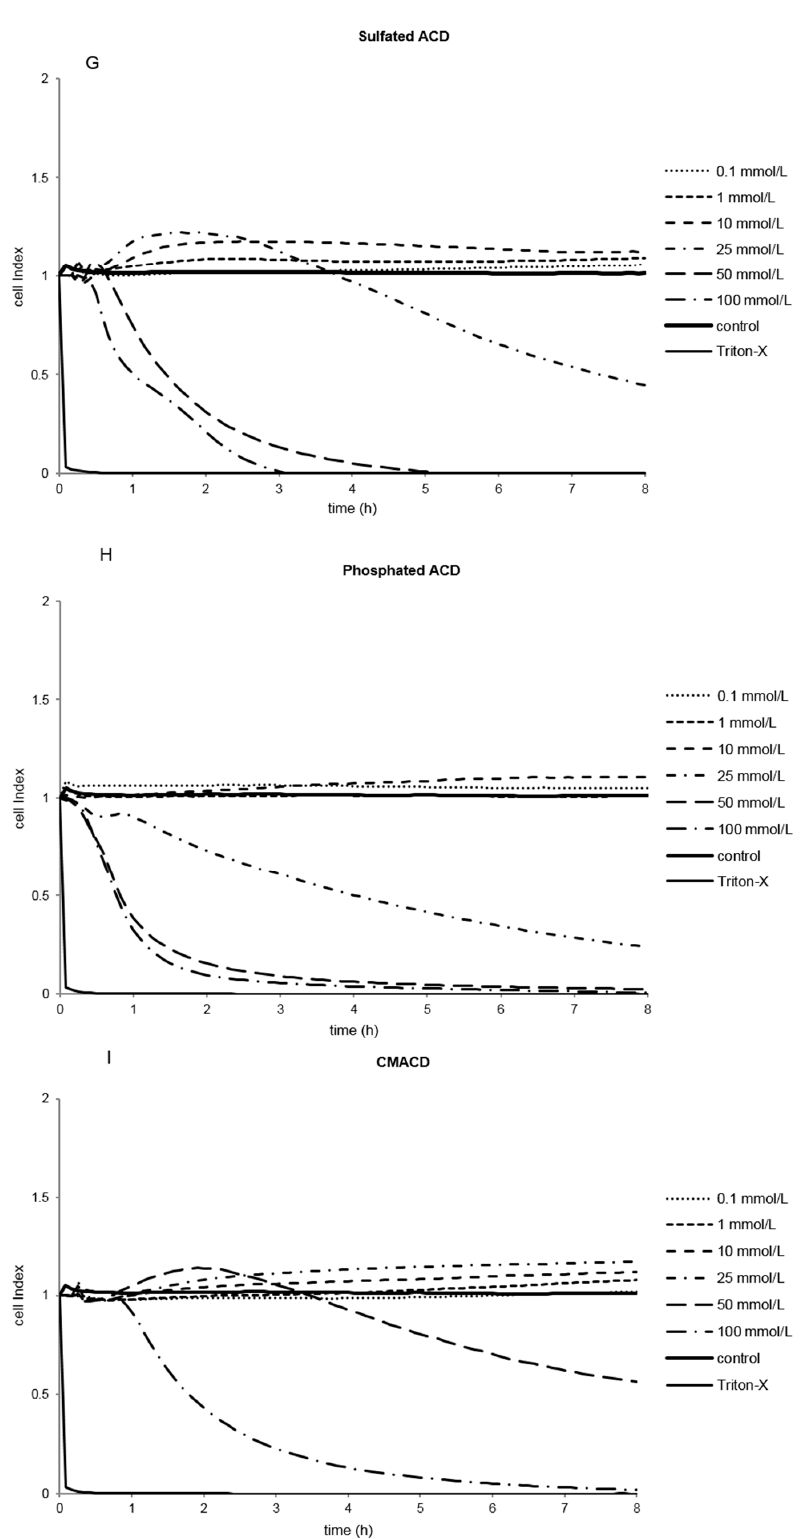
Figure 3. Effect of non-ionic ( A – F ) and ionic ( G – I ) α -CD derivatives on Caco-2 cell viability, determined by Real Time Cell Electronic Sensing. Changes in cell index indicating viability of Caco-2 cells up to 8 h treatment with different α -CD derivatives. Data are presented as mean ± S.D: n = 3 parallel samples. Positive control: 1% Triton X-100 detergent. Negative control: PBS.